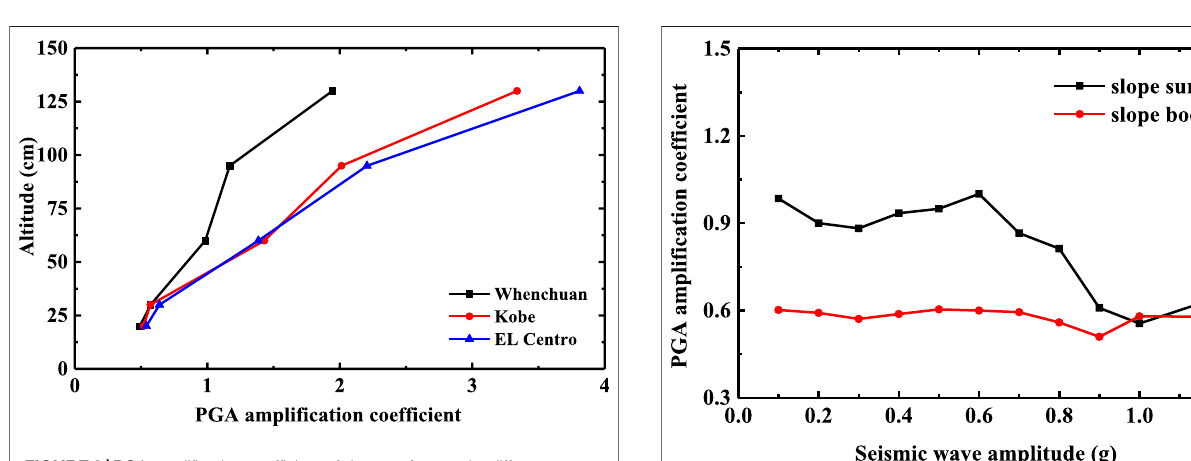
FIGURE8| PGAampli fi cationcoef fi cientofslopesurfaceunderdifferent seismic wave.